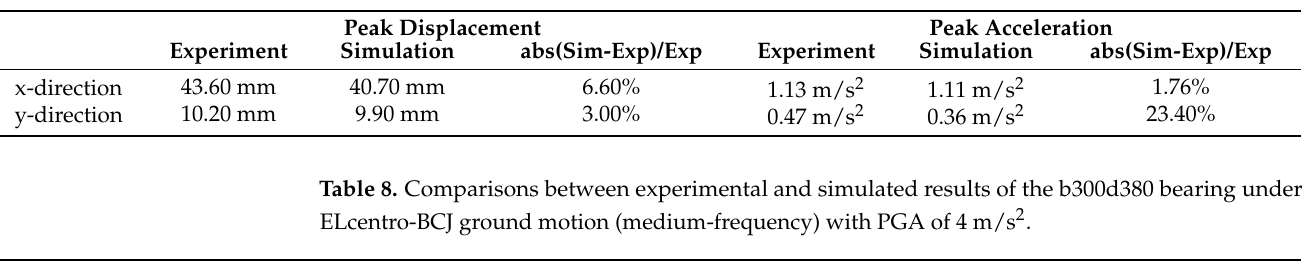
Table 7. Comparisons between experimental and simulated results of the b300d380 bearing under Wo-long ground motion (high-frequency) with PGA of 6.2 m/s 2 .